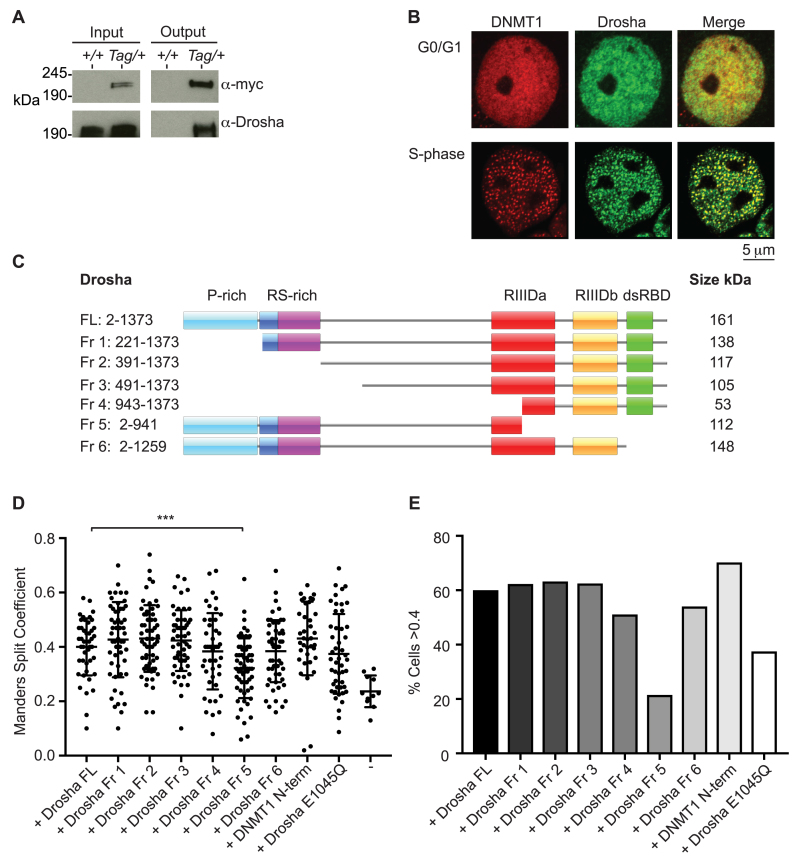
Drosha interacts and co-localizes with Dnmt1. (A) Western blot using anti-Drosha antibody following immunoprecipitation with anti-FLAG M2 magnetic beads on material from wild-type (+/+) and Dnmt1Tag/+ (Tag/+) ES cells. (B) Immunofluorescence micrographs of COS-7 monkey kidney cells co-transfected with DsRed-DNMT1 and HA-Drosha constructs. (C) Cartoon showing different fragments of Drosha examined and the domains they encompass. (D) Scatter plot showing distribution of cells with different Manders Split Coefficient values corresponding to co-localization between DsRed-DNMT1 and the different HA-Drosha constructs indicated. ‘–’ indicates cells transfected with DsRed-DNMT1 only. Dnmt1 N terminal fragment contains amino acids 2–452. Exact Mann–Whitney P-values of different fragments compared to distribution using full-length HA-Drosha are Fr1 (0.0201), Fr2 (0.2872), Fr3 (0.3934), Fr4 (0.4197), Fr5 (0.0001), Fr6 (0.3403), DNMT1 N-term (0.1636) and Drosha E1045Q (0.211). (E) Bar graph showing percentage of cells analysed with Manders Split Coefficient values of >0.4. Images from at least 50 cells were analysed per construct.